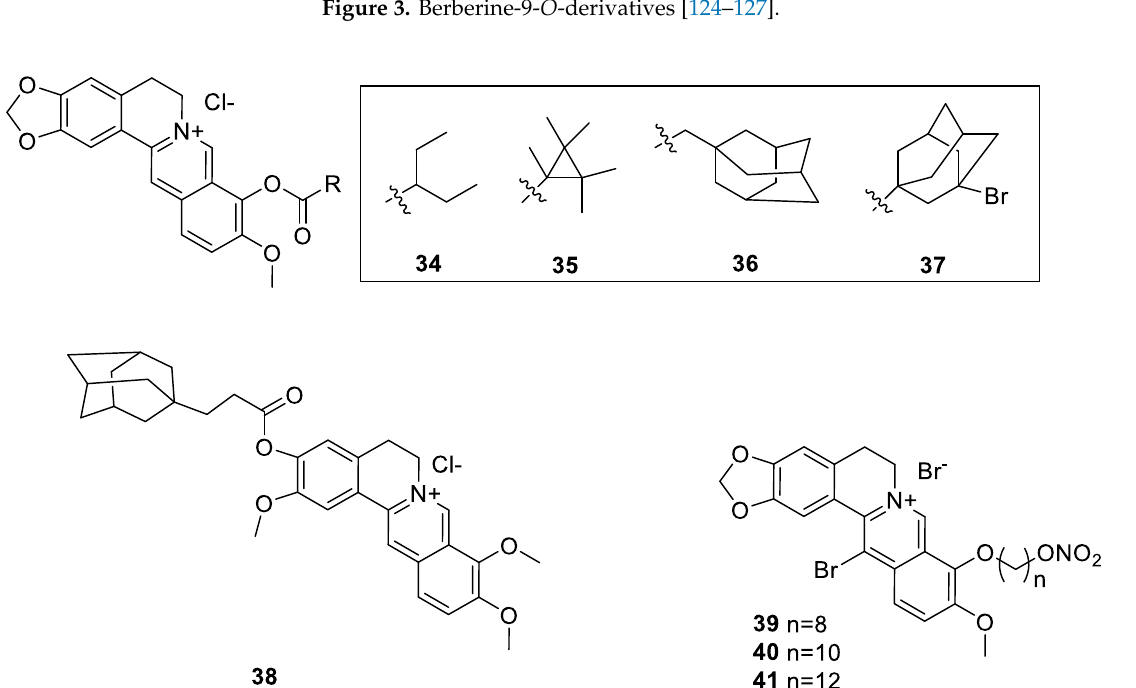
Figure 4. Berberine-3- O - and 9- O -derivatives [128,129].